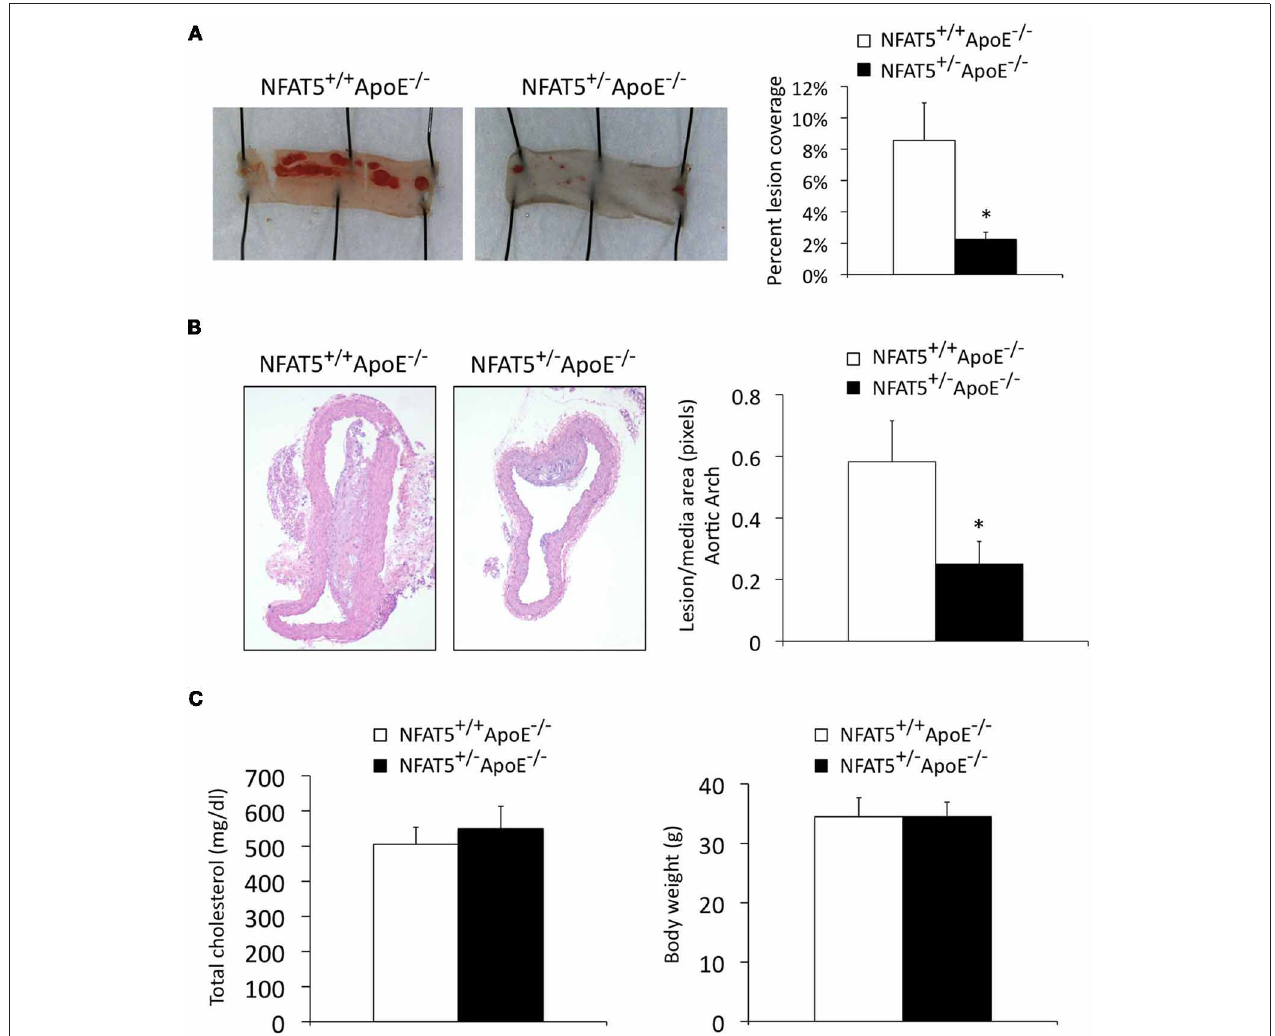
FIGURE 2 | Genome-wide NFAT5 haploinsufficiency inhibits atherosclerotic lesion formation. Mice were placed on a high fat diet for 20 weeks. (A) En face Sudan IV staining and analysis of the thoracic aorta.